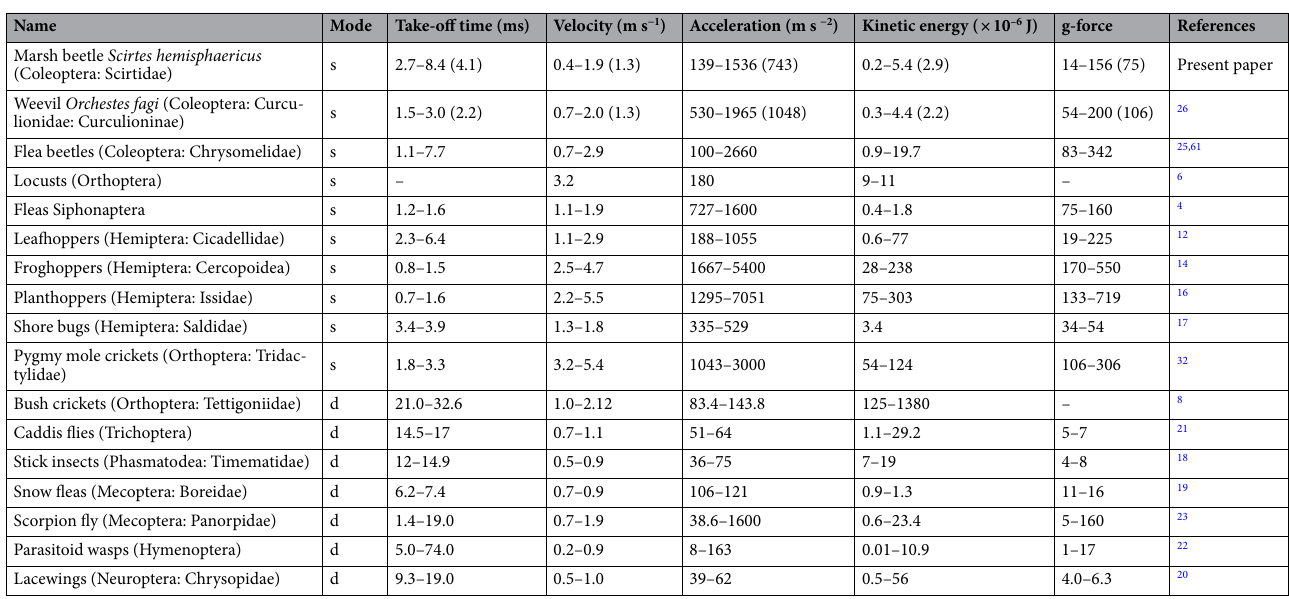
Table 1. Kinematic parameters of jumping in the marsh beetle Scirtes hemisphaericus (Coleoptera: Scirtidae) in comparison with other jumping insects, average values in brackets. Mode of jumping: s spring-actuated mechanism, d direct muscle